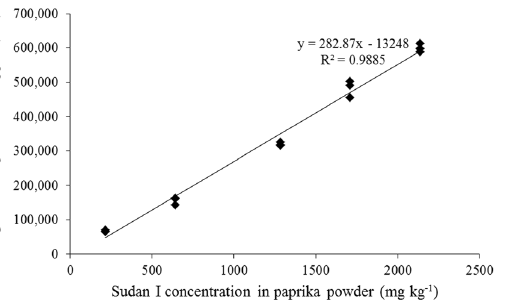
Figure 6. Linear regression model for quantitative analysis of Sudan I in paprika powder by 1 H HR MAS SSNMR